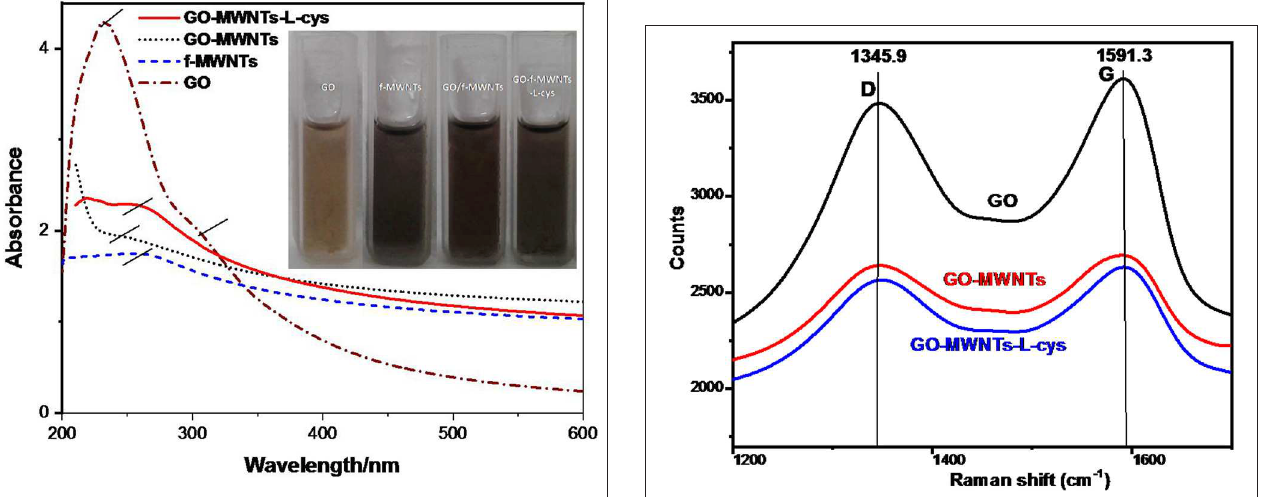
Frontiers in Materials |